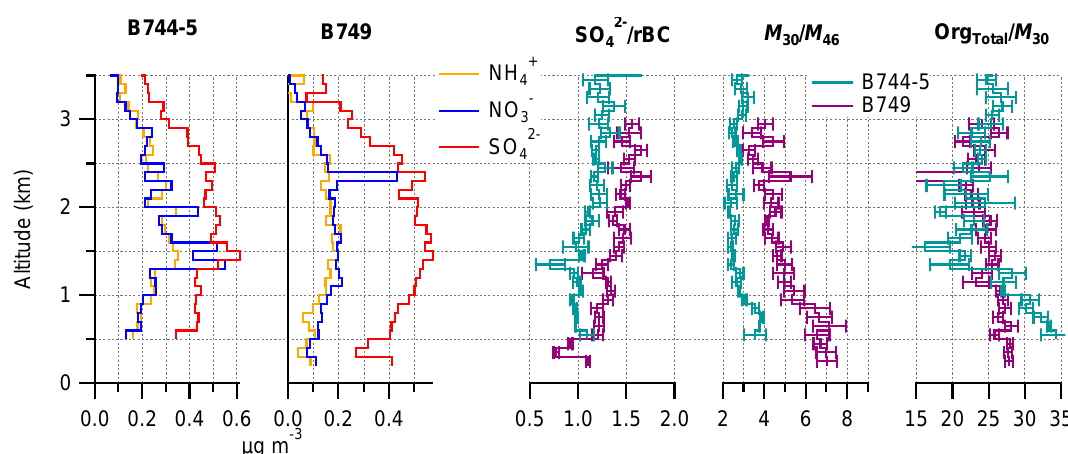
Figure 5. Inorganic vertical profiles for B744-5 and B749. Data above 3.5km are omitted for